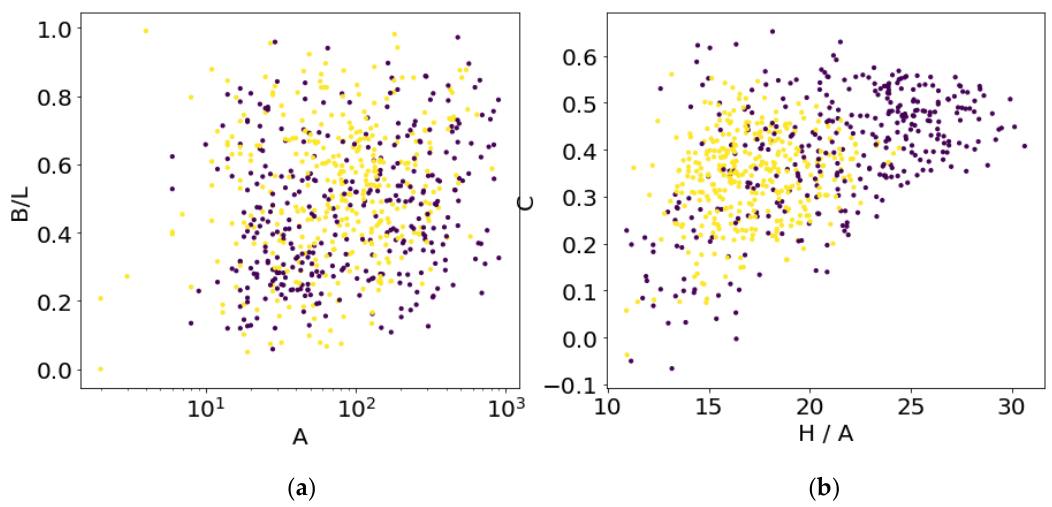
Figure 7. Scatter plots of SAR ships (blue) and icebergs (yellow) classified according to ( a ) breadth B to length L ratio vs. area A, ( b ) cross-polarization HV/H vs. average object backscatter H/A (in dB). Table 3. Accuracies in % for the models and datasets. For the Nuuk MSI dataset, the SVM accuracy is calculated by assuming that CNN is 100% accurate (see text).